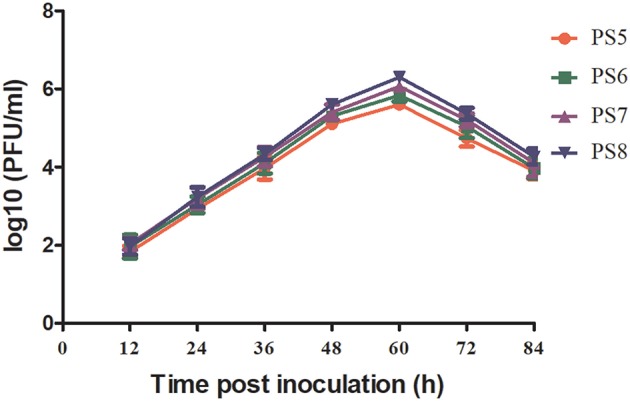
TMUV growth kinetics in BHK-21 cells. Virus titers in plaque-forming units (PFU)/ml were measured between 12 and 84 hpi with a 12 h interval.